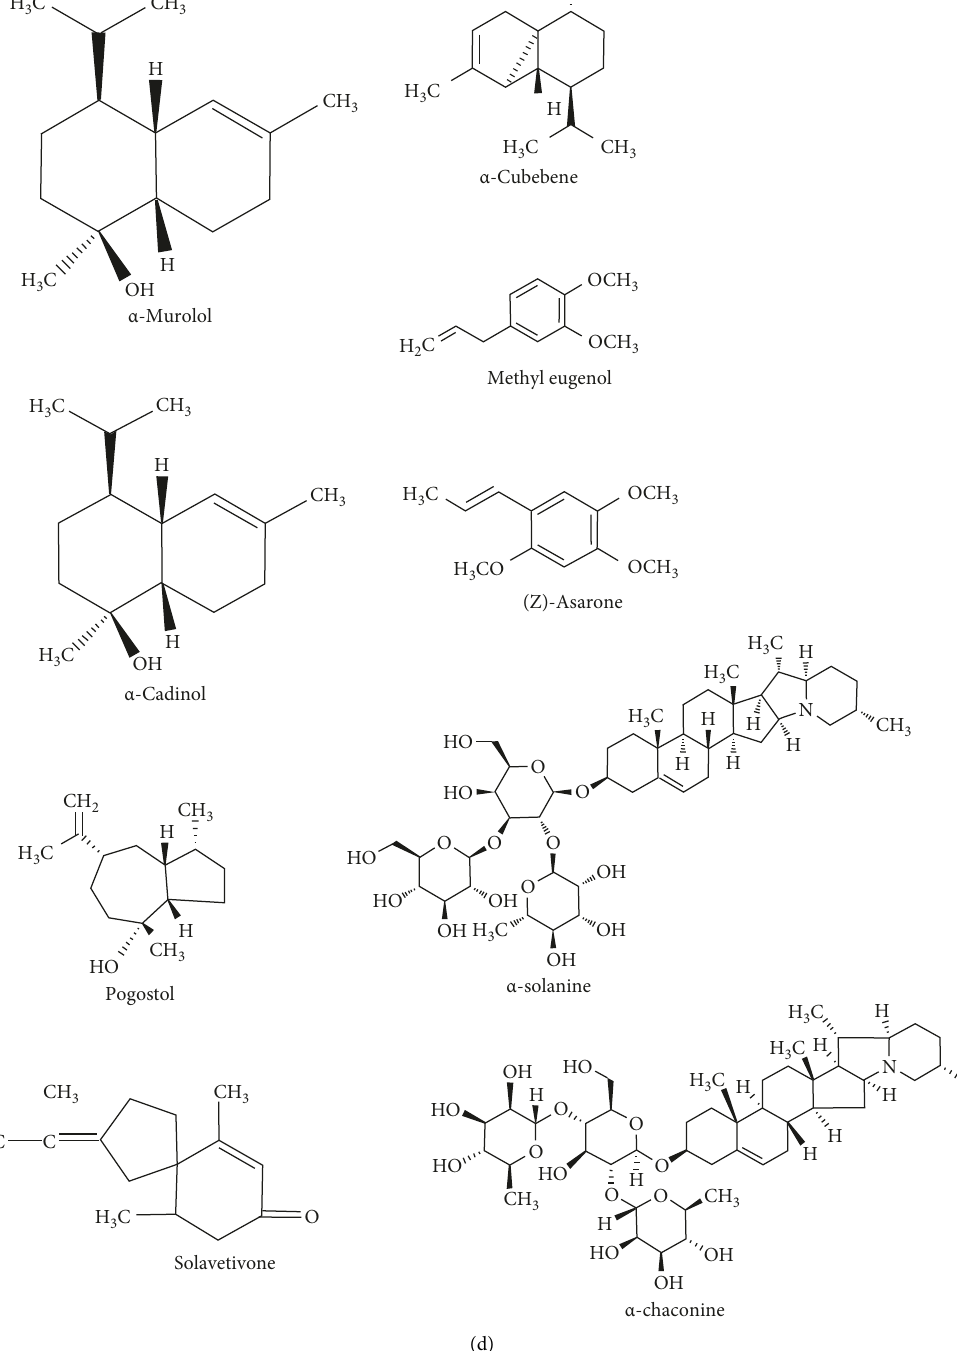
Figure 2: Chemical structures of insecticidal and mosquitocidal phytochemicals isolated from various Solanum